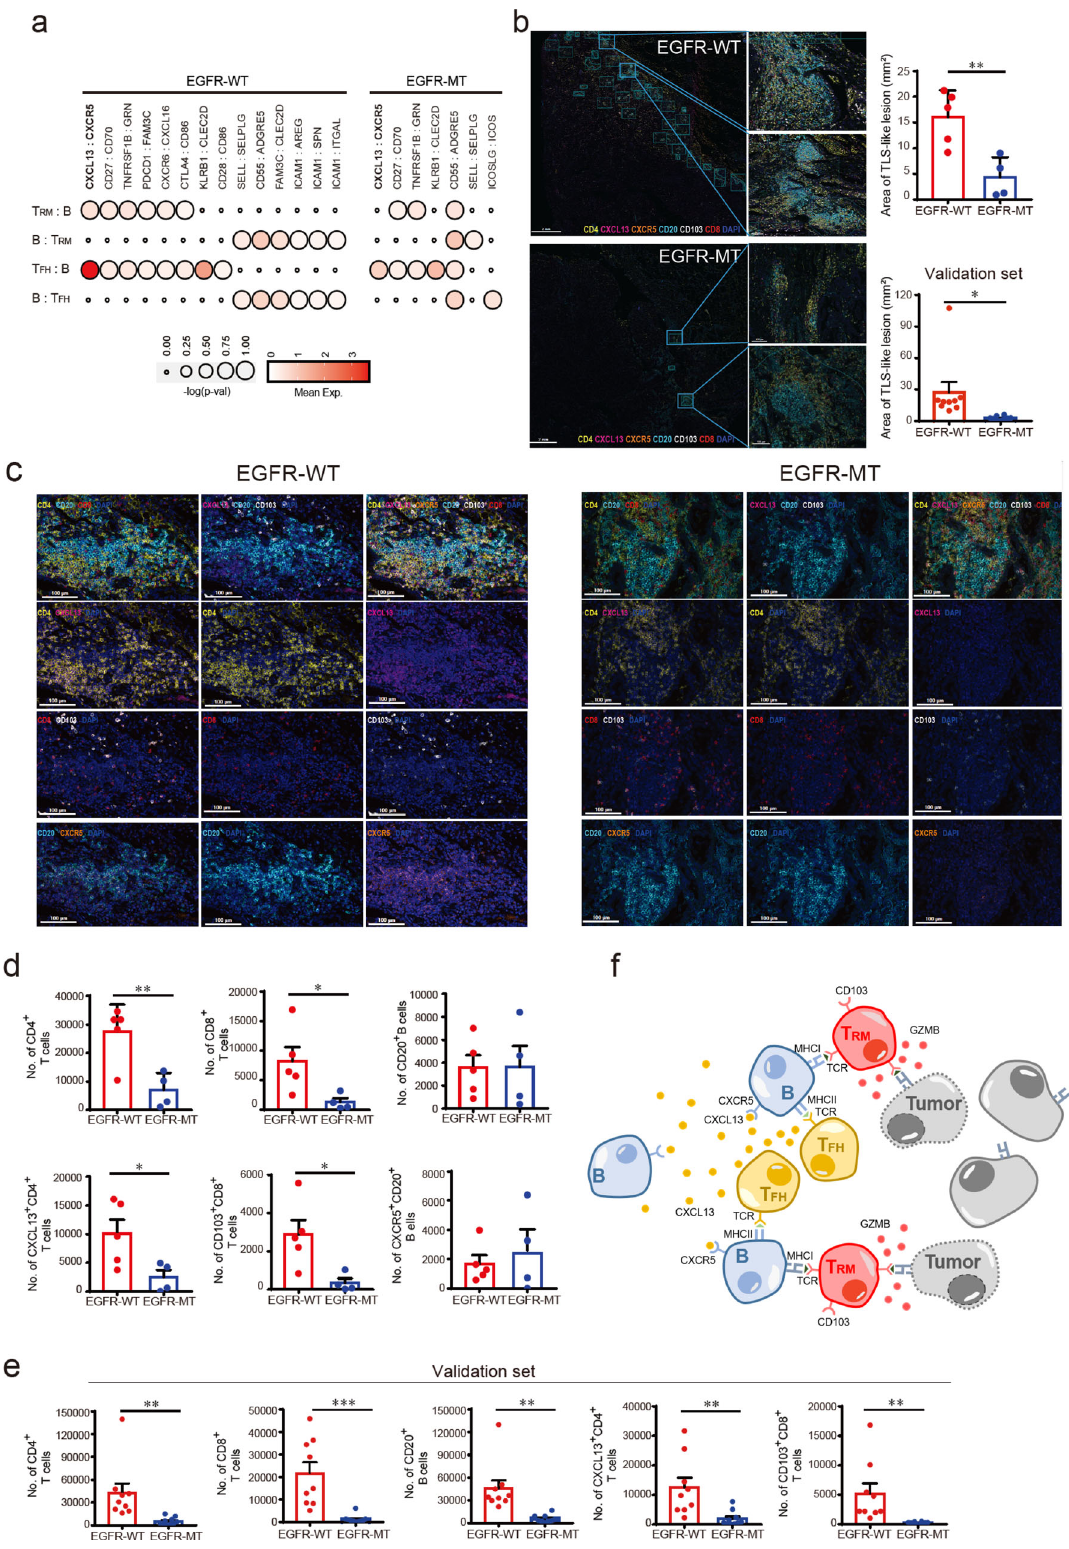
immunity in TME of NSCLC through single-cell RNA velocity and co-regulatory network analysis, we could not provide functional validations in the present study. Thus, we need to conduct further experimental analyses in vitro and in vivo conditions to con fi rm our proposed mechanisms in future